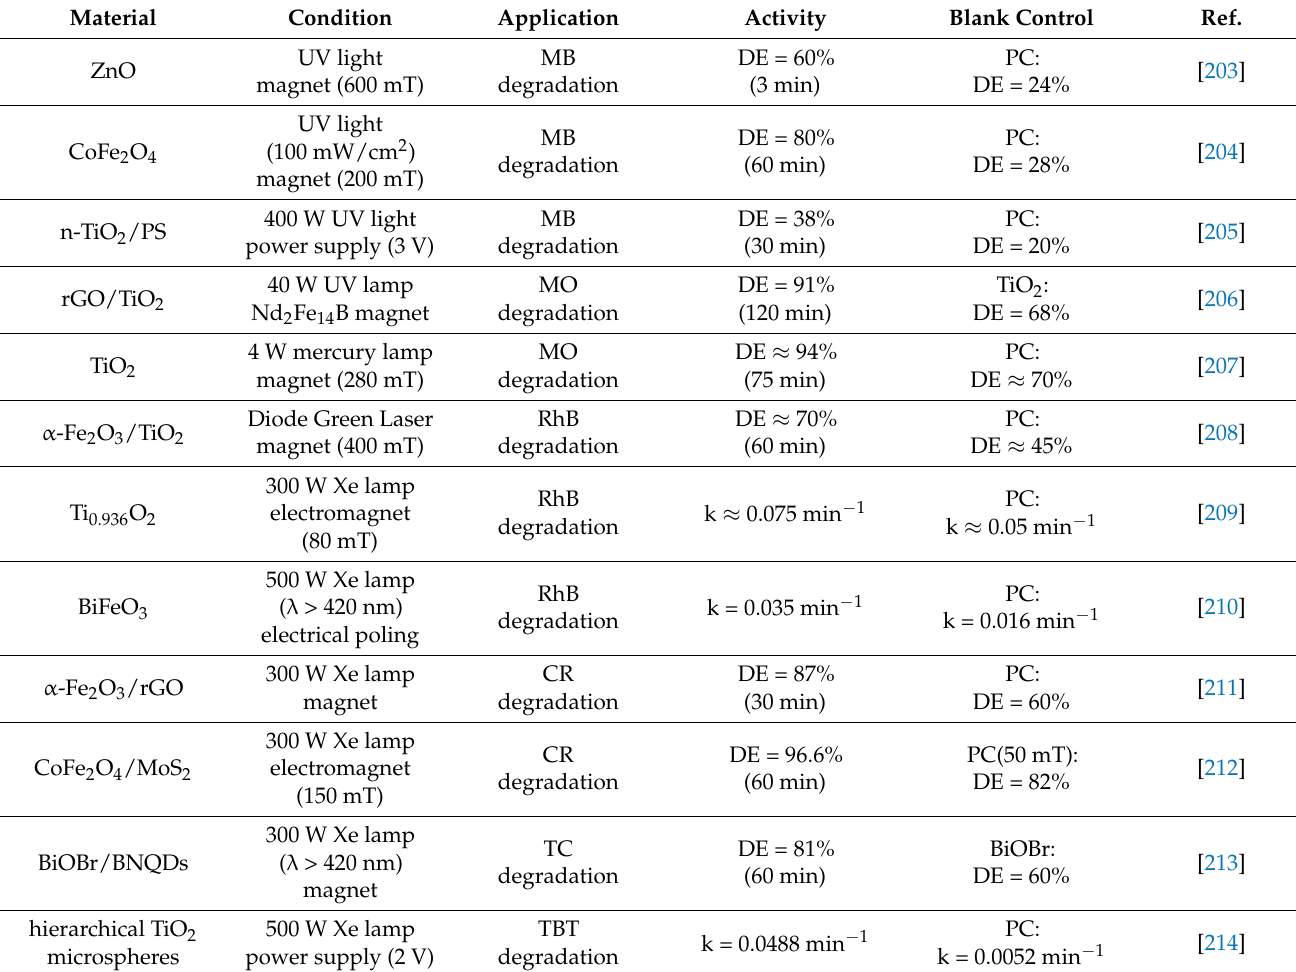
Table 3. Summary of electromagnetism-coupled photocatalysis in recent years.